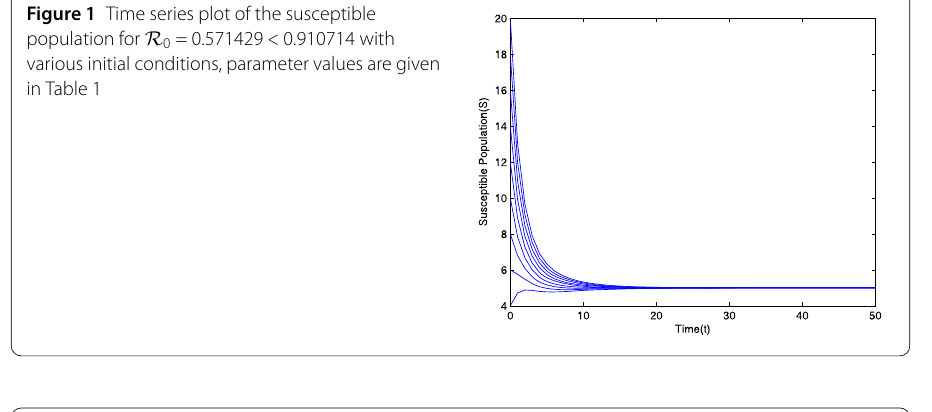
Figure 2 Time series plot of the exposed population for R 0 = 0.571429 < 0.910714 with